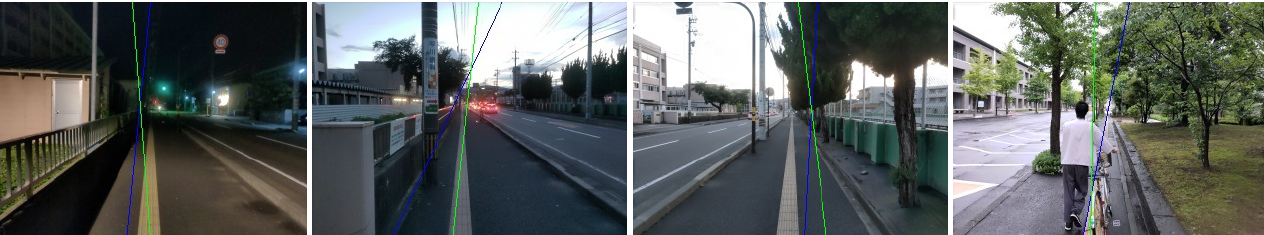
Figure 9. Examples of failure defections. 1st ∼ 3rd examples show the case of illumination change and the last example shows the case of